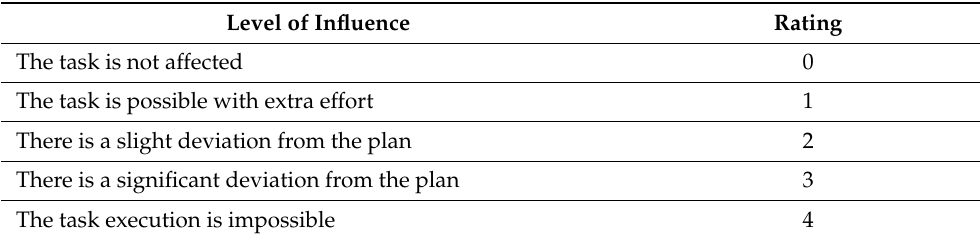
Table 1. A scale for evaluating the impact of inconsistencies on the task. Level of Influence Rating The task is not affected 0 The task is possible with extra effort 1 There is a slight deviation from the plan 2 There is a significant deviation from the plan 3 The task execution is impossible 4